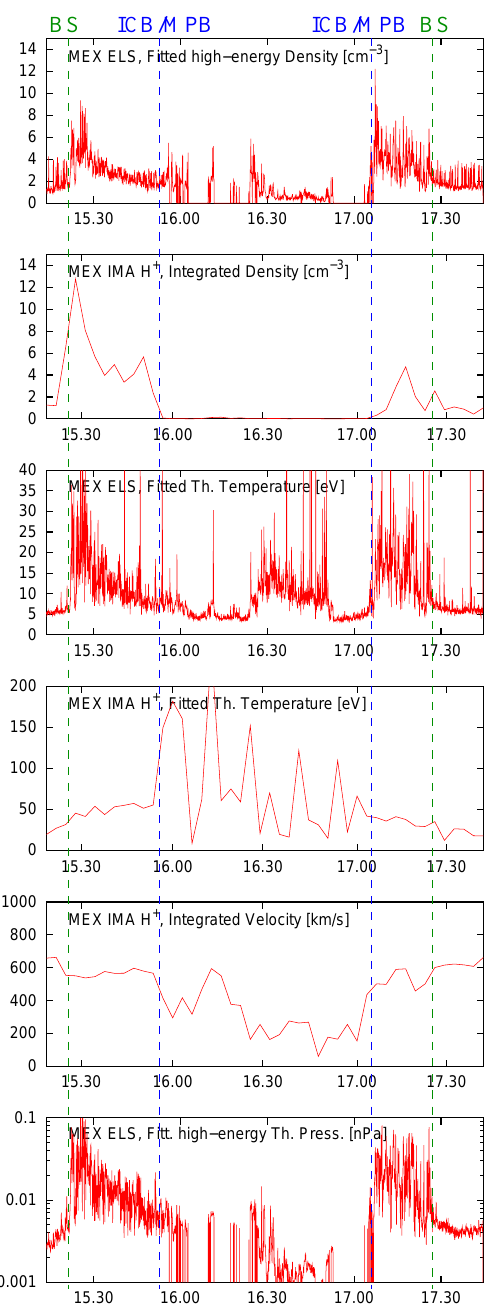
Fig. 3. Mars Express ELS and IMA data. This figure shows from top to bottom: electron density calculated from the high energy part of the spectrum, proton density integrated from the full enery range of the spectrum, electron temperature calculated from a fit to the whole spectrum, proton temperature calculated from a fit to the whole spectrum, integrated proton velocity and thermal electron pressure calculated from the high energy part of the